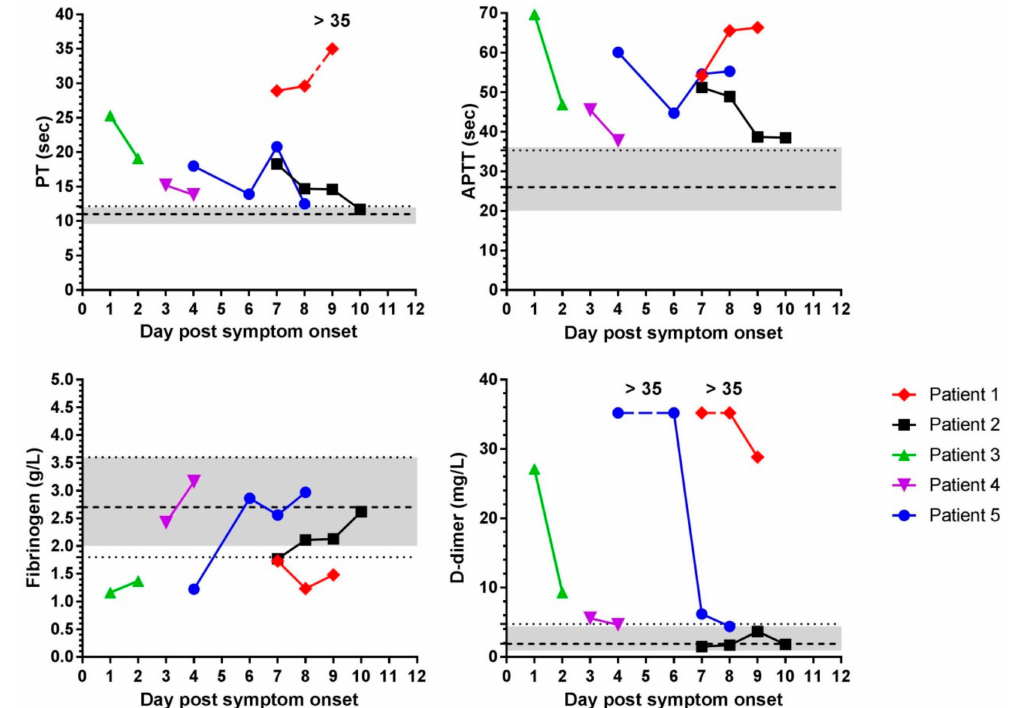
Figure 2. Changes in haemostasis parameters over time in Ebola virus-infected individuals. Mean values of Prothrombin Time (PT), Activated Partial Thromboplastin Time (APTT) (top row) and fibrinogen, and D-Dimer values (bottom row) from plasma samples collected without centrifugation from five patients are shown. Each time-point was tested in at least duplicate and mean plotted. Each patient is represented by a di ff erent colour and symbol and days of sampling post-symptom onset were di ff erent for each patient. Grey shaded area indicates the range of values for each test obtained from naïve ‘normal’ human donor samples also collected without centrifugation (Figure 1). Dashed line is the mean value from the un-centrifuged non-infected samples and the dotted line is the value of the un-centrifuged mean + 3 standard deviations (for fibrinogen—3 standard deviations also shown with a second dotted line). If data distribution is approximately normal, then 99.7 % lies within three standard deviations. One PT result and several D-dimer results were out of range and are plotted at the upper limit of the test and indicated as such for each data